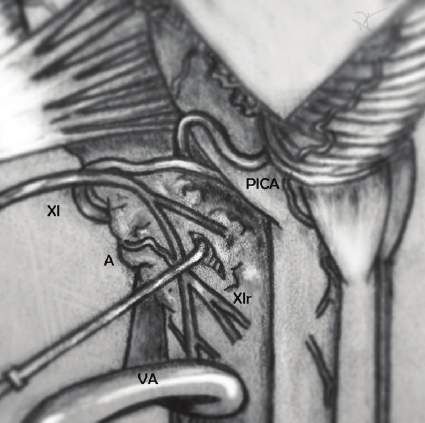
Figure 5: Intraoperative illustration detailing the surgical corridor from a far lateral approach. XI: cranial nerve 11; A: abnormality; VA: vertebral artery; XIr: cranial nerve 11 rootlet; PICA: posterior inferior cerebellar